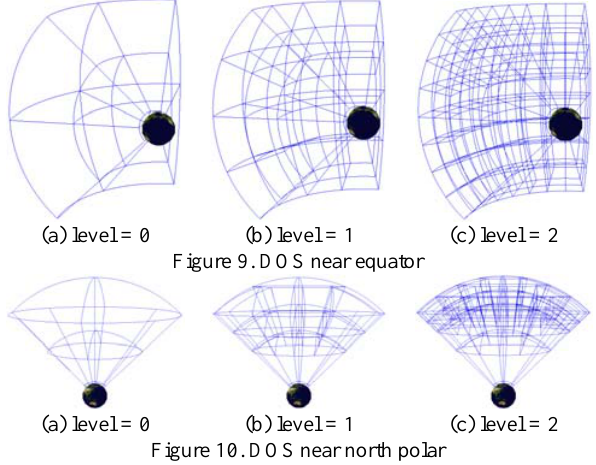
Figure 10. DOS near north polar